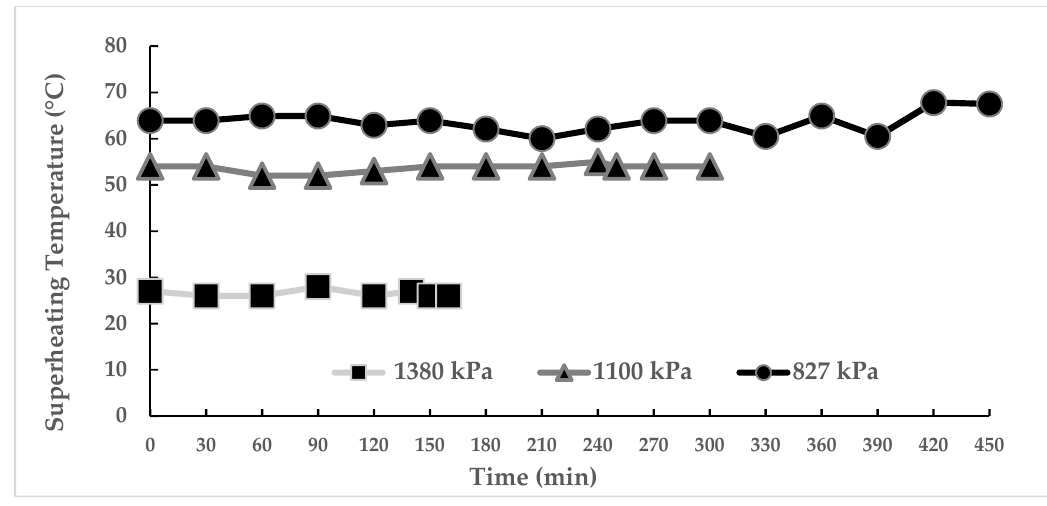
Figure 8. Superheating profile for all operation discharge pressure.